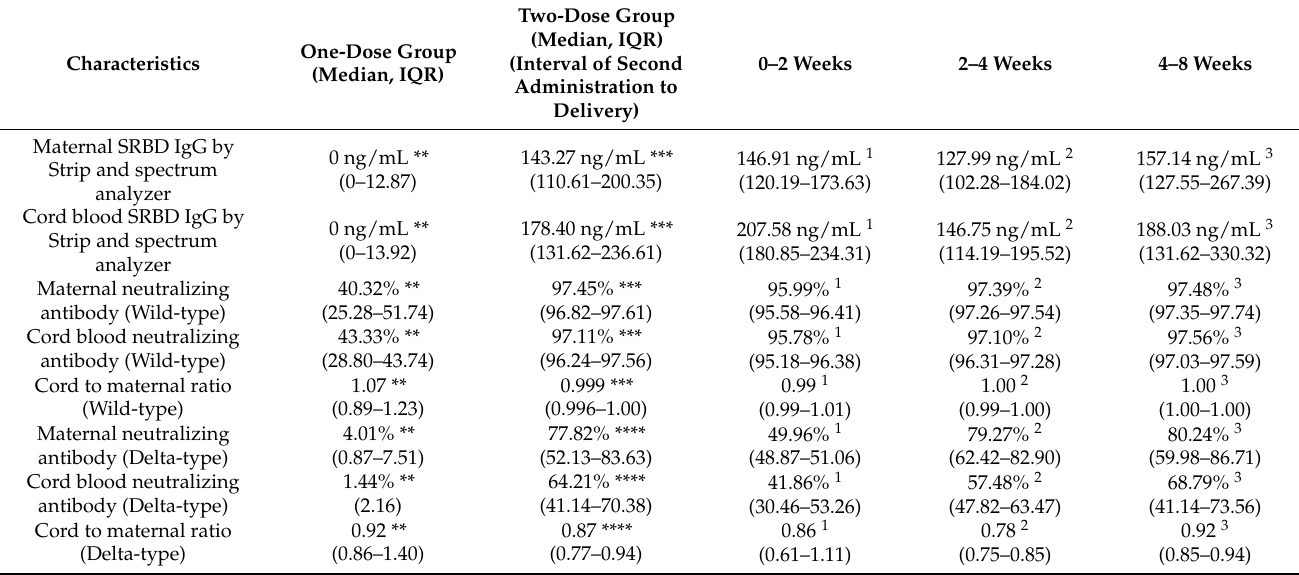
Table 1. Neutralizing antibodies against wild-type and Delta-type SARS-CoV-2 in maternal serum and neonatal cord blood